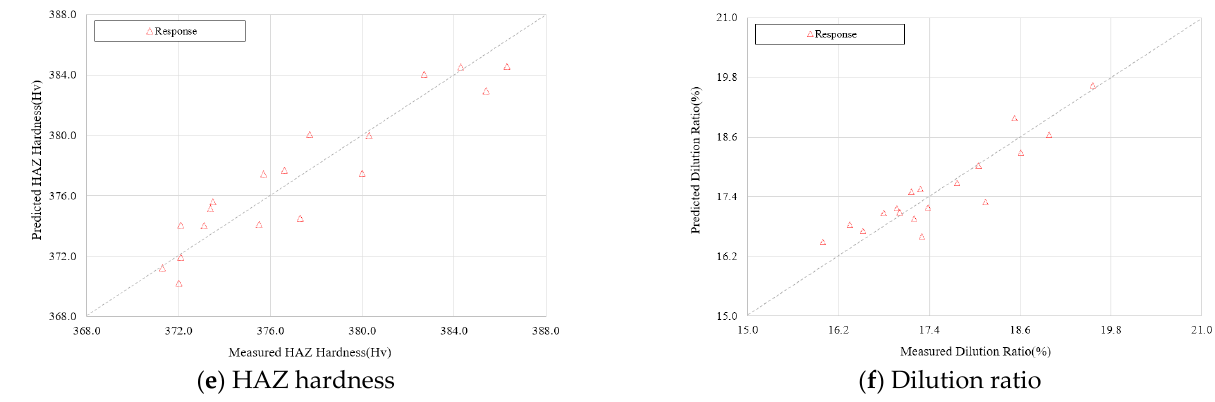
Figure 9. Comparison between measured and predicted welding factors according to the mathematical model: ( a ) penetration width, ( b ) penetration depth, ( c ) upper hardness, ( d ) bottom hardness, ( e ) HAZ hardness and ( f ) dilution ratio. Table 11. Analysis variance tests for predicted model for welding factors.